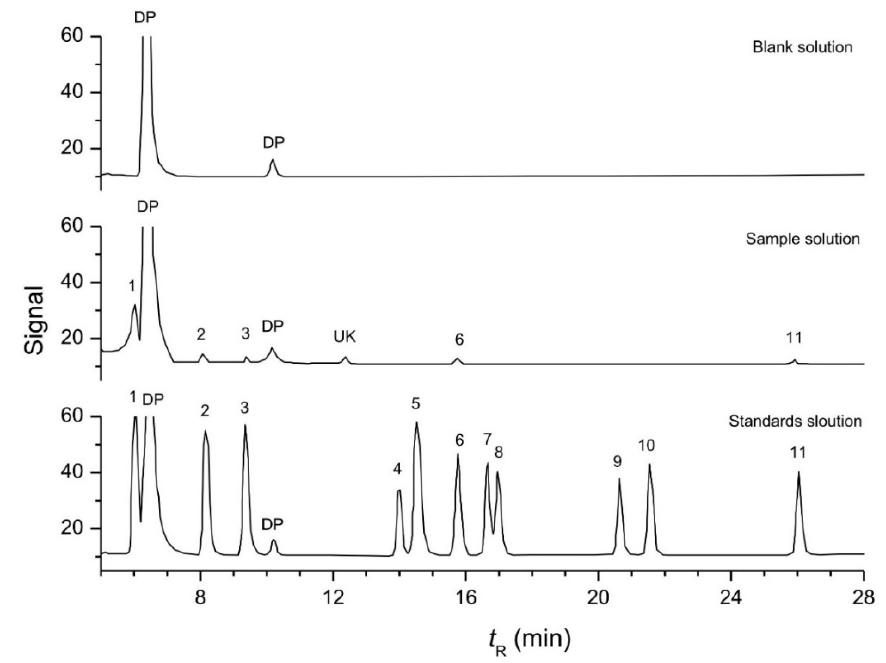
Figure 1. HPLC chromatogram of the blank sample, wine sample and standards’ solution of biogenic amines. The numbers correspond to amines reported in Table 4, DP—derivation peak, UK—unknown peak.